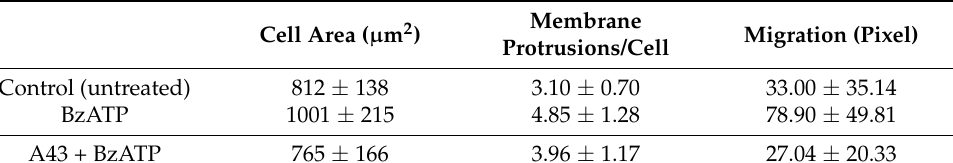
Table 1. Statistics on data depicted in Figures 2 and 3 obtained after 3 h of time-lapse video microscopy. Values represent the means and the standard deviation (SD). A pixel corresponds to 0.5 µ m.